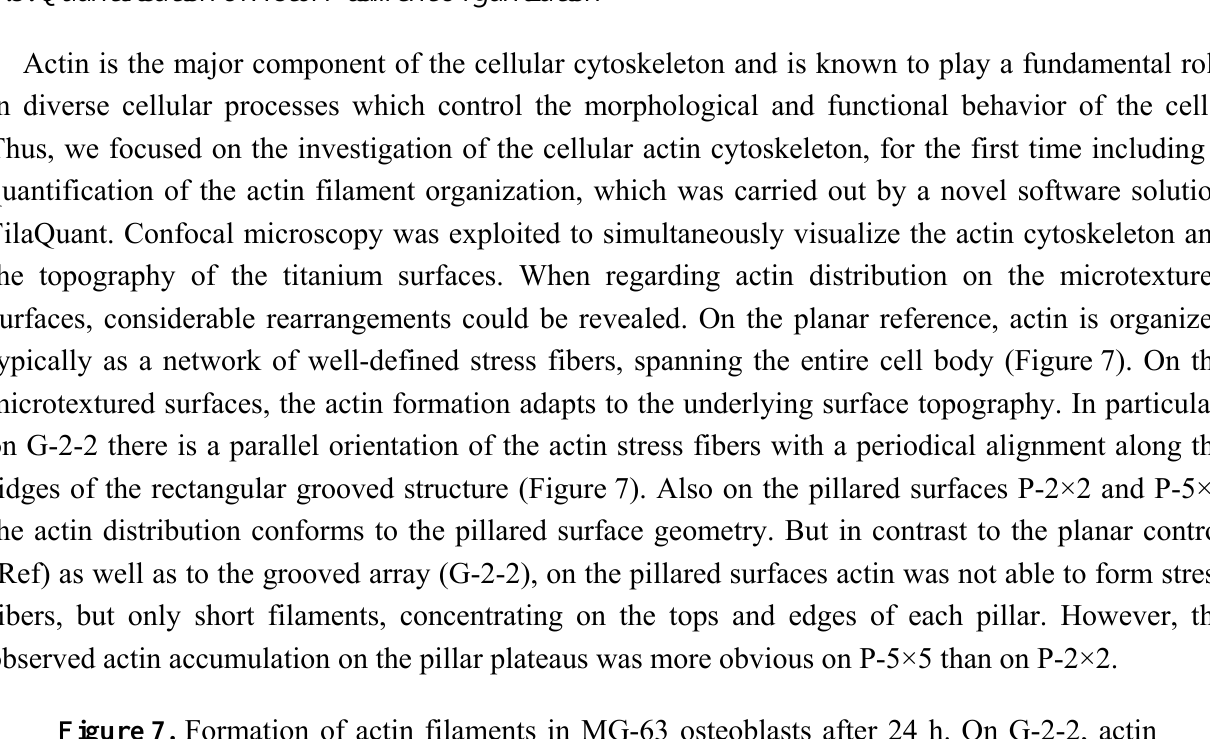
Figure 7. Formation of actin filaments in MG-63 osteoblasts after 24 h. On G-2-2, actin stress fibers orient themselves parallel to and along the ridges of the grooves. On the pillar structure (P-2×2, P-5×5) the actin cytoskeleton is strongly accumulated on the top of the pillars in short fibers within one cell’s dimension (LSM 410, Carl Zeiss, green: reflexion mode from the surface, red: phalloidin-TRITC for